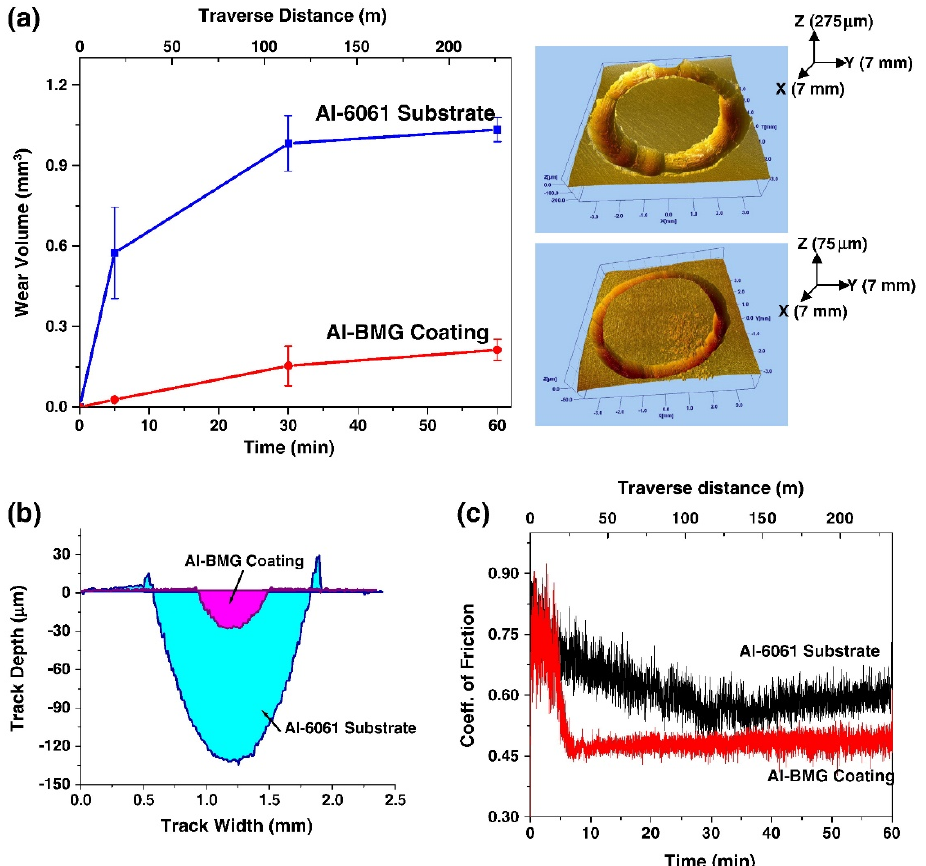
Figure 4. ( a ) Wear volume vs. time plot with respective SPM (Scanning Probe Microscope) images for tracks at 60 min, ( b ) profile of the track across the width after 60 min, ( c ) coefficient of friction vs. time plot for Al-BMG (Al-bulk metallic glass) coatings and Al-6061 substrate. Reprinted with permission from [53] Copyright 2021 Elsevier.